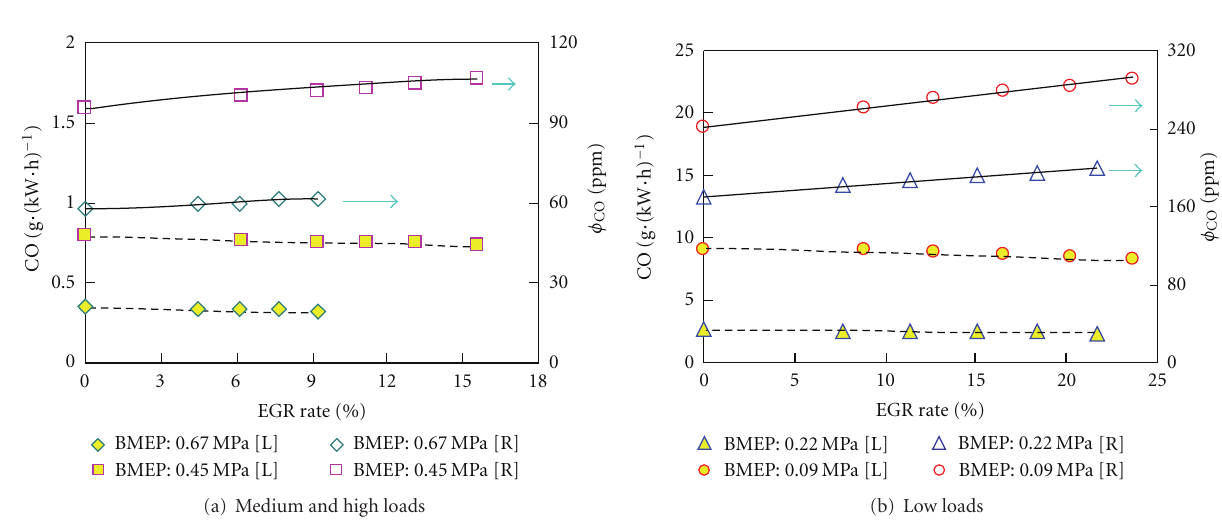
Figure 8: E ff ects of EGR on the CO